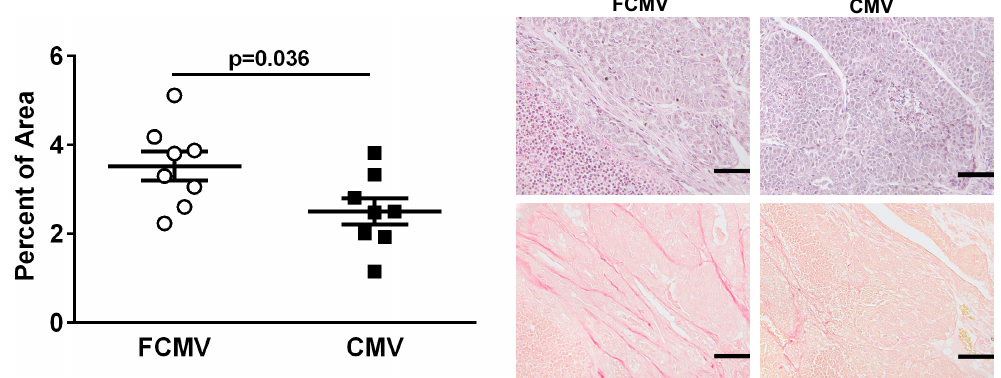
Figure 3. The tumors from MMTV-PyVT mice latently infected with mCMV had a lower collagen content. Collagen was quantified as the percent of total area in sections from the largest breast tumors from n = 8 mice in each group. Representative matched sections taken from the same area of the breast tumors were stained with hematoxylin and eosin for the detection of nuclei (top) and for collagen using picro-sirius red (bottom). The images were taken with a 20 × magnification lens. Scale = 100 µ m. The p -values were calculated by Student’s t -test.